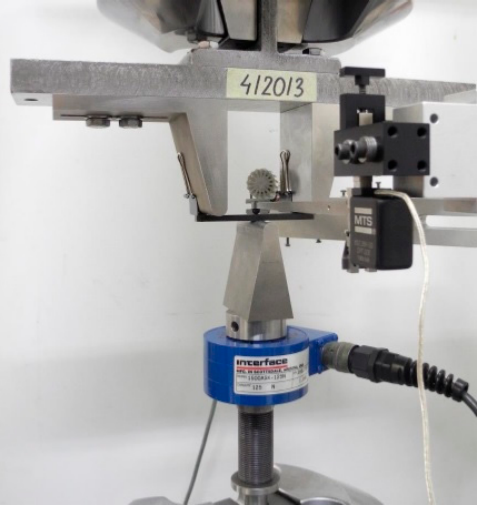
Figure 8. View of the sample fixed in the strength machine before the test.